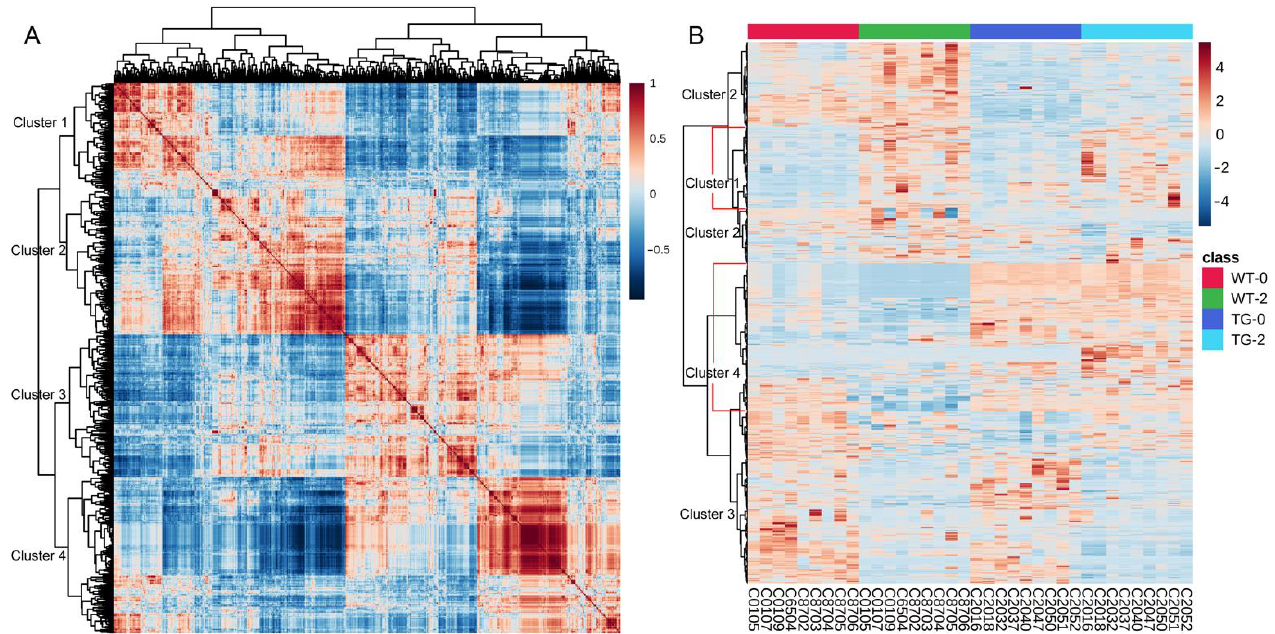
Figure 2. Hierarchical clustering of the 815 differential features comparing the four groups. ( A ) The correlation map between the 815 differential metabolites and lipids. ( B ) Heatmap showing the abundance of the 815 differential metabolites and lipids in each sample.